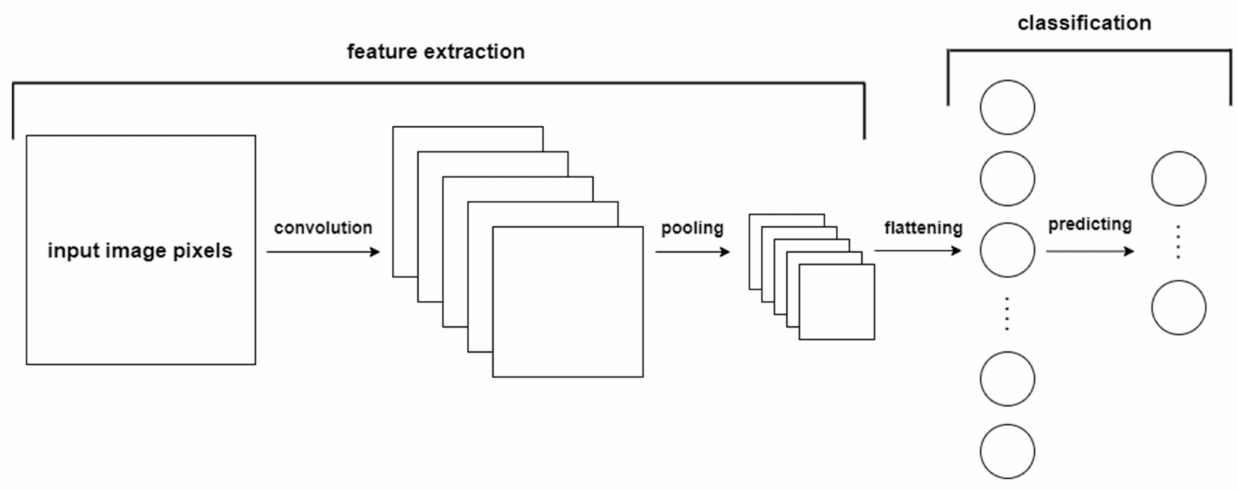
Figure 2. Standard CNN